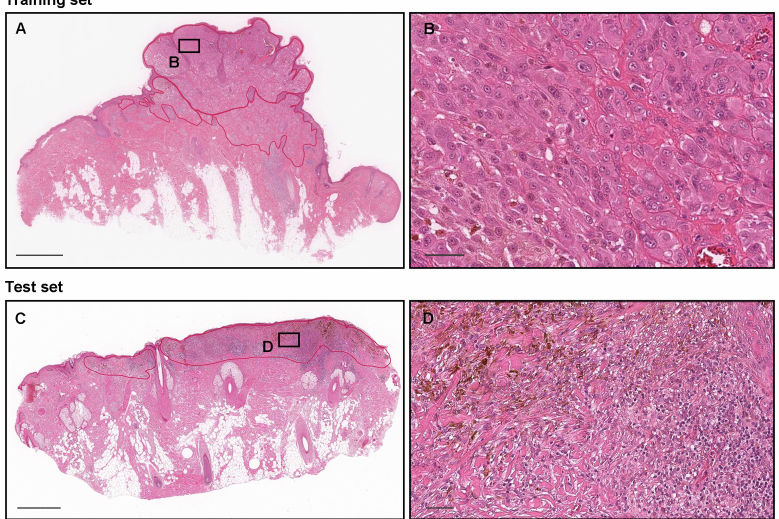
Figure 1. A manual drawing of an annotation for melanoma labels on whole-slide images (WSIs). In both training ( A ) and test ( C ) sets, the melanoma cell-infiltrating areas ( B , D ) were manually annotated (red lines) as melanoma labels. The test set of melanoma WSIs was annotated due to the tile-based evaluation. Scale bars: 1 mm ( A , C ) and 50 µ m ( B , D